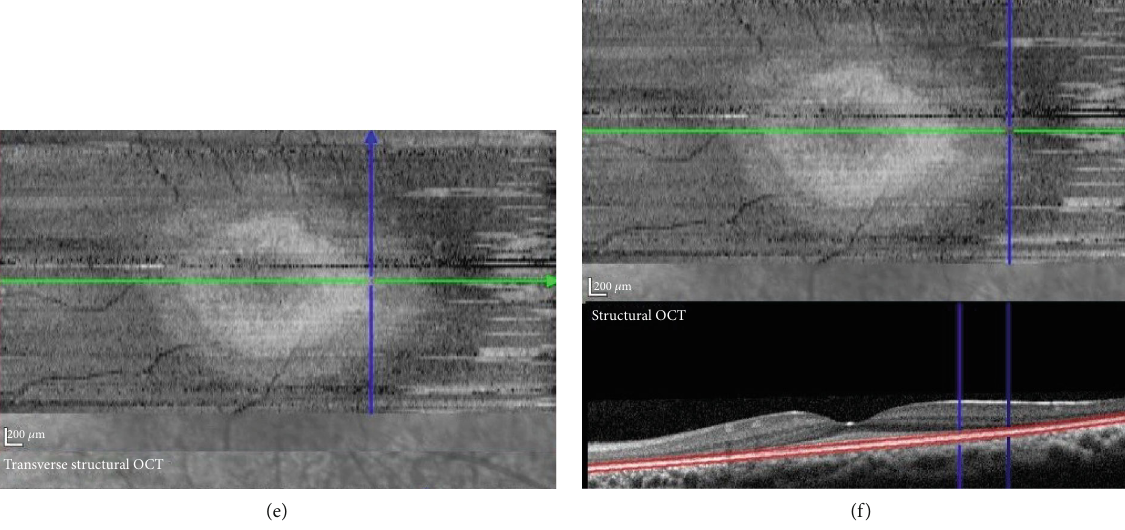
Figure 3: Fundus infrared imaging revealed hyperre fl ective ring centred in the fovea and hypore fl ective areas in temporal parafoveal regions in both eyes (a, b). En face SD-OCT images at the level of the outer retina revealed two hyperre fl ective rings corresponding to the disruption of the ellipsoid zone (c, e) and ELM (d, f). SD-OCT: spectral domain optical coherence tomography; ELM: external limiting membrane.